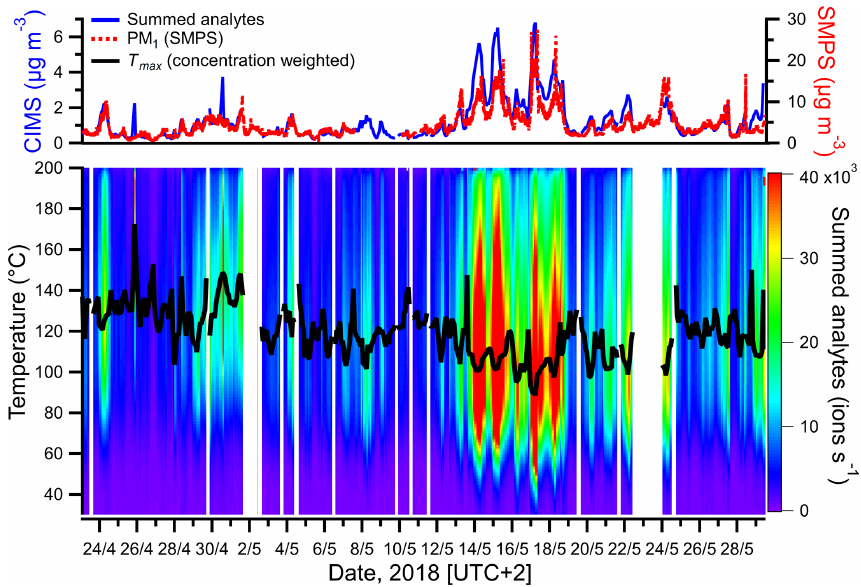
Figure 1. Comparison between the total summed analytes (excluding reagent ions) measured in the particle phase by FIGAERO-CIMS and particle mass concentration (PM 1 ) calculated from SMPS size distribution measurements (upper panel) and thermograms of the summed analytes during each FIGAERO cycle (lower panel). The black line represents the concentration-weighted T max for each measurement